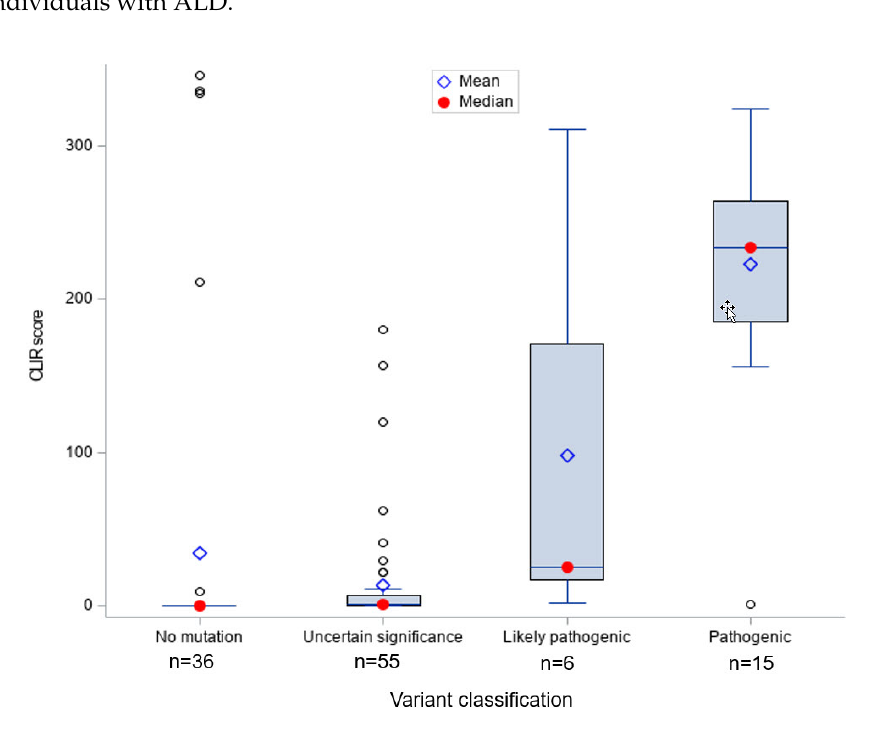
Figure 1. Collaborative Laboratory Integrated Reports (CLIR) peroxisomal disorders (POX) adrenoleukodystrophy (ALD) score distribution by ABCD1 variant classification . Note: Each o represents an outlier data point.